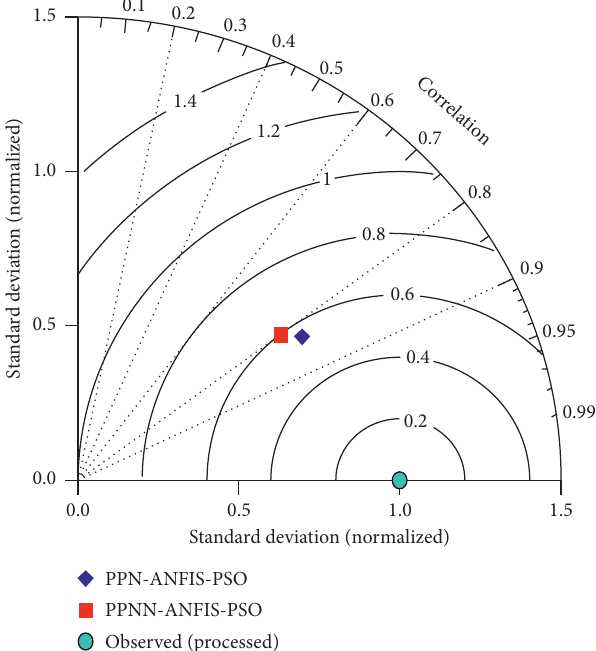
Figure 9: Normalized Taylor diagram visualization of the best applied predictive models over the testing